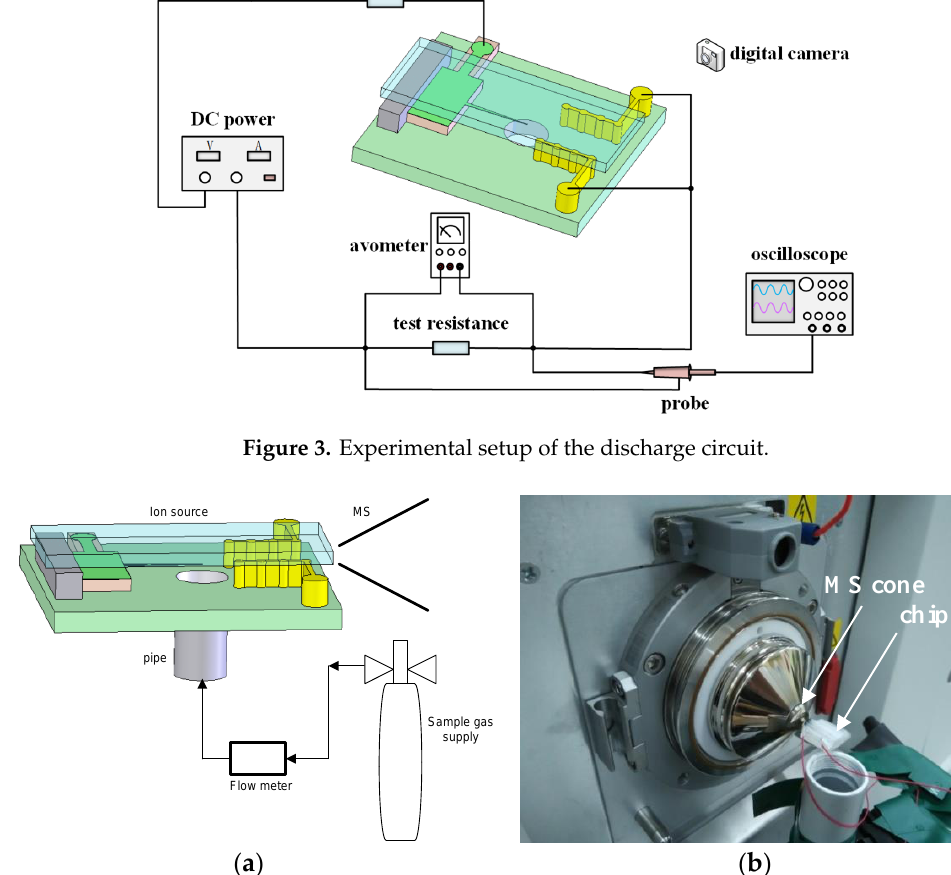
Figure 4. Schematic diagram of the chip-MS instrument. ( a ) Schematic of the experiment. ( b ) Experimental setup.